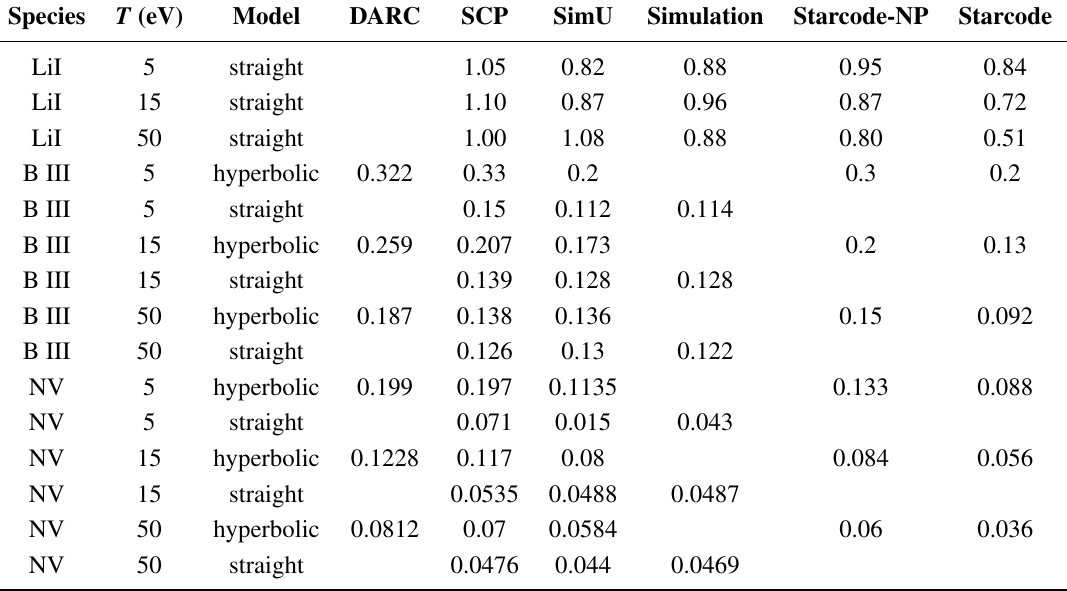
Table 1. 2s-2p Transition width (FWHM) comparisons. All widths are in cm − 1 and normalized to a density of 10 17 e/cm 3